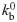
Influence of the crosslinker’s mechanical and kinetic properties on the organization of the actin network.(A-D) Organization of 135nm-long actin filaments at the end of the simulation (t = 50s) for different values of extensional stiffness κext, torsional stiffness κtor, and breakage rate kb0, as indicated above the figure. (E) Local nematic order parameter Slocal as a function of the extensional stiffness κext, with κtor = 10pN ⋅ nm ⋅ rad−1 and kb0=10s-1. (F) Local nematic order parameter Slocal as a function of the torsional stiffness κtor, with κext = 0.1pN/nm and kb0=10s-1. (G) Local nematic order parameter Slocal as a function of the strain-free breakage rate kb0, with κtor = 10pN ⋅ nm and κext = 1pN/nm. In (E-G), simulations were performed for filaments of various lengths: 81nm (blue), 135nm (red), 189nm (orange). For each simulation, the means of Slocal were calculated from the data between t = 40s to 50s and the error bars indicate standard deviation over 10 simulations. Slocal corresponding to the networks in panels (A-D) are identified by the red symbols with corresponding shapes.